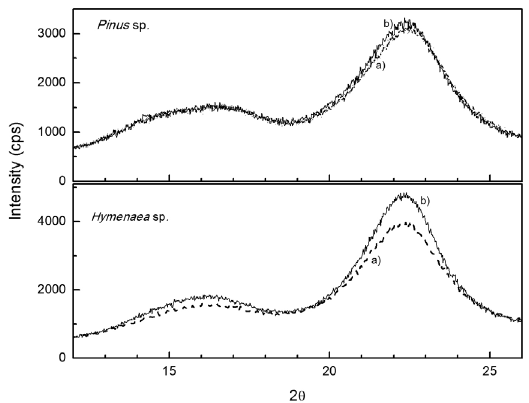
Figure 3. Diffractograms for Pinus sp . and Hymenaea sp . a) without any surface treatment (or inoculated fungus), and b) with oleoresin capsaicin and inoculated